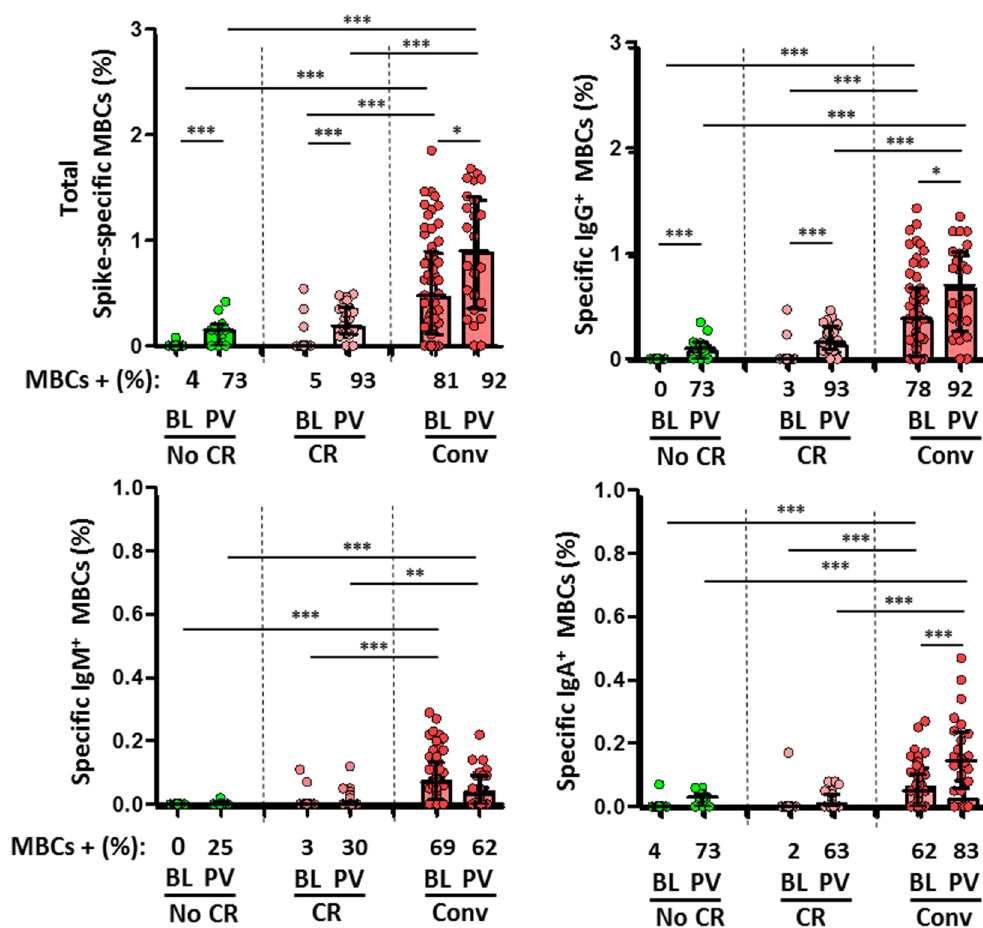
Figure 3. Comparison of specific memory B-cells (MBCs, top left ) and IgG+ MBC ( top right ), IgM+ MBCs ( bottom left ), and IgA+ MBCs ( bottom right ) isotypes between the different subgroups at baseline (BL) and after two doses of vaccine (PV, post-vaccination). No CR (unexposed without cross-reactivity, green dots and bars), CR (unexposed with cross-reactivity, rose dots and bars), and Conv (convalescent, red dots and bars). Frequencies are indicated at the X axis. Statistically significant when p < 0.05. * = p < 0.05, ** = p < 0.01, and *** = p < 0.001.